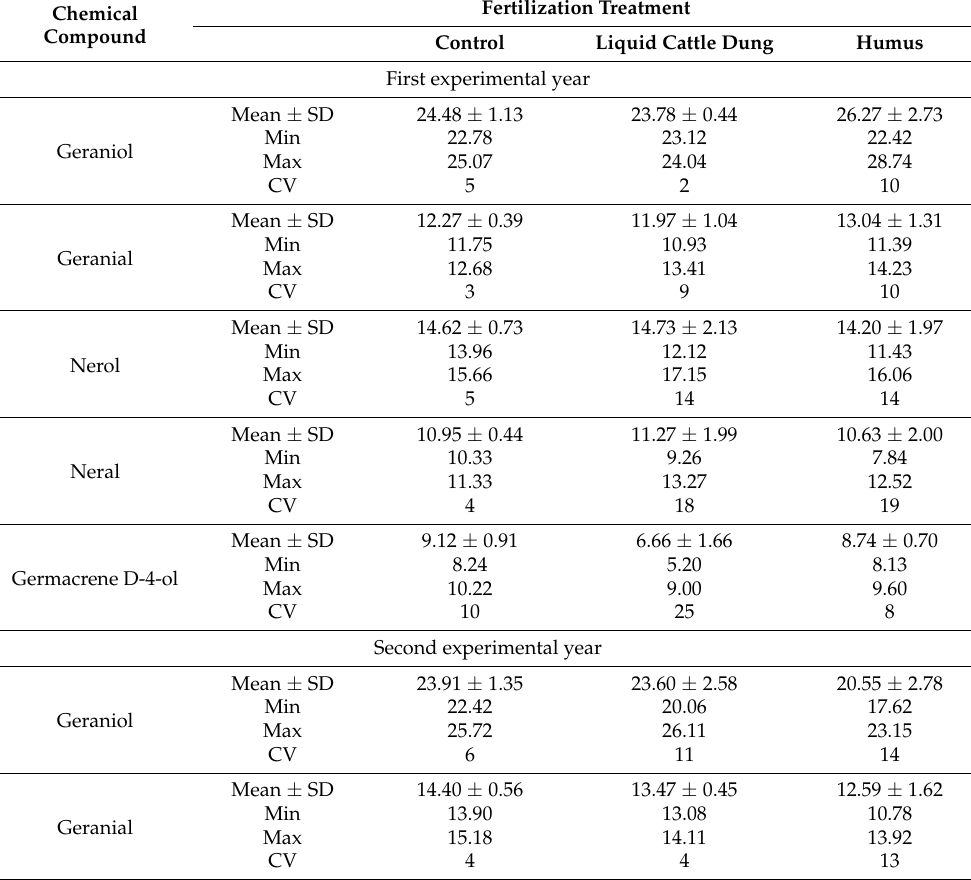
Table A1. Descriptive statistics of some chemical compounds of Thymus × citriodorus essential oil depending on fertilization treatment in the first and the second experimental year. SD—standard deviation, CV—coefficient of